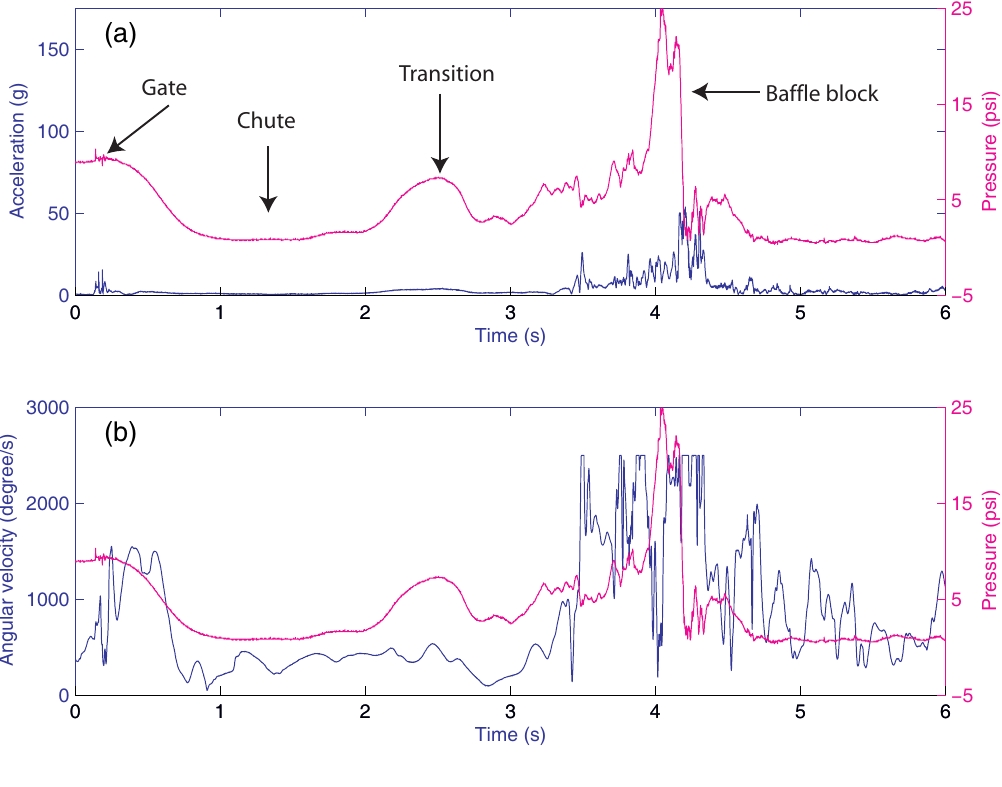
Figure 9 . An example of measurements by Sensor Fish released from Bay 6 at The Dalles Dam spillway: (a) acceleration; (b) rotational